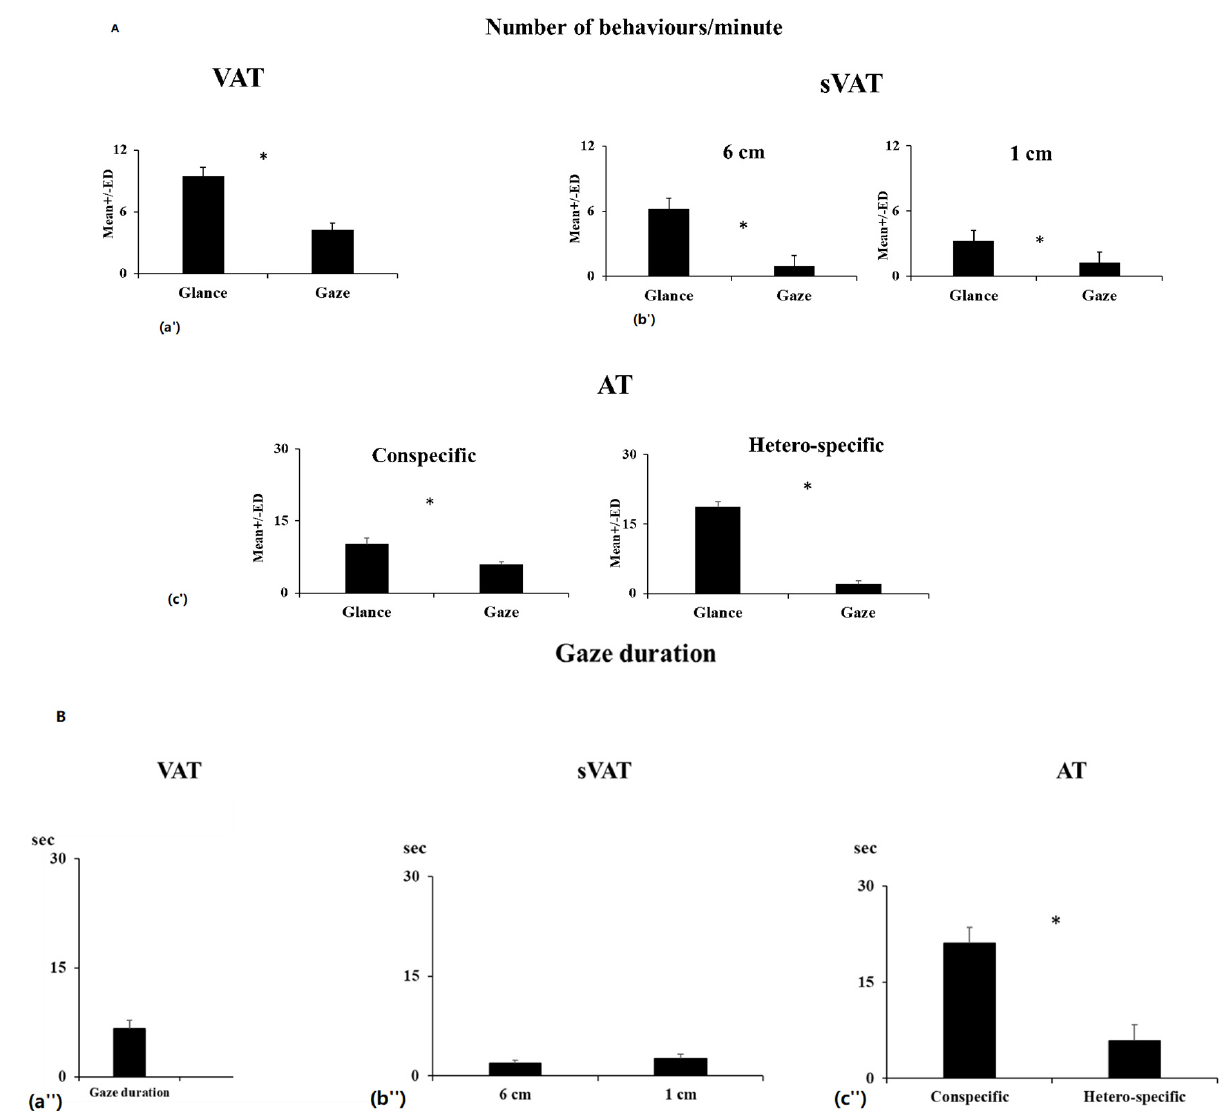
Figure 2: ( A ). Attention characteristics during tests: occurrences of glances and gazes, ( B ): duration of gazes during stimulus presentation, (data: mean number per minute ± ED [52], *: Wilcoxon test: p ≤ 0.05): ( a ) Non-social visual test (VAT). ( b ) Social visual test (sVAT) with maximum opening (6 cm) and minimum opening (1 cm). ( c ) Auditory test (AT): attention characteristics after the broadcast of conspecific vocalizations and hetero-specific (Whale).